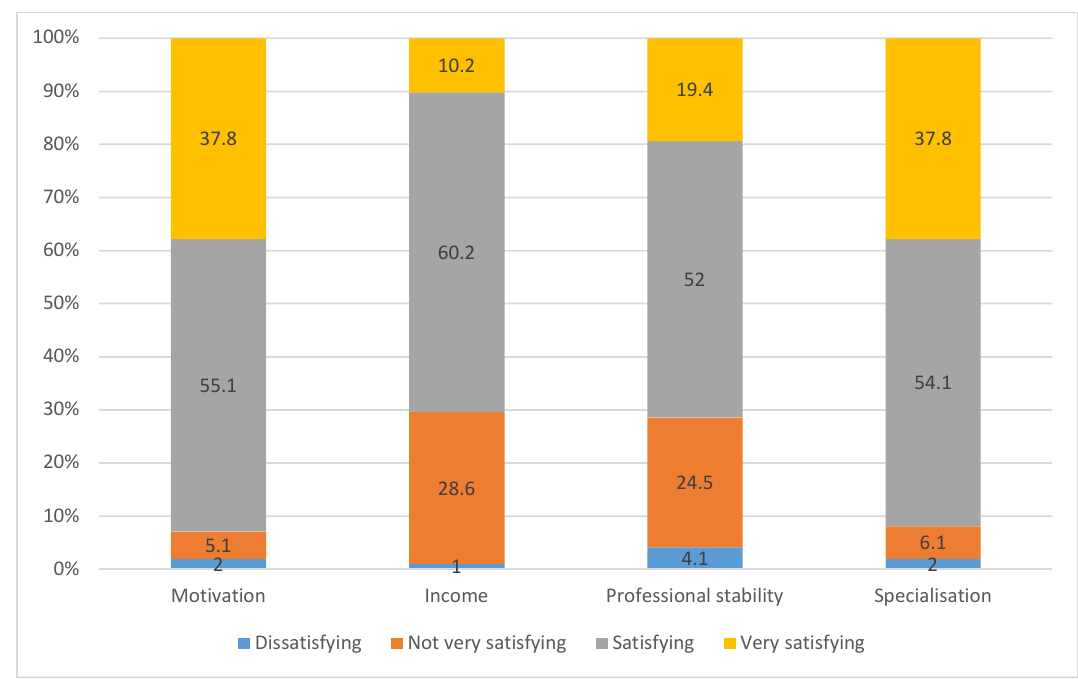
Figure 2 - Overall satisfaction of the interviewee, relative to their professional position. n = 98